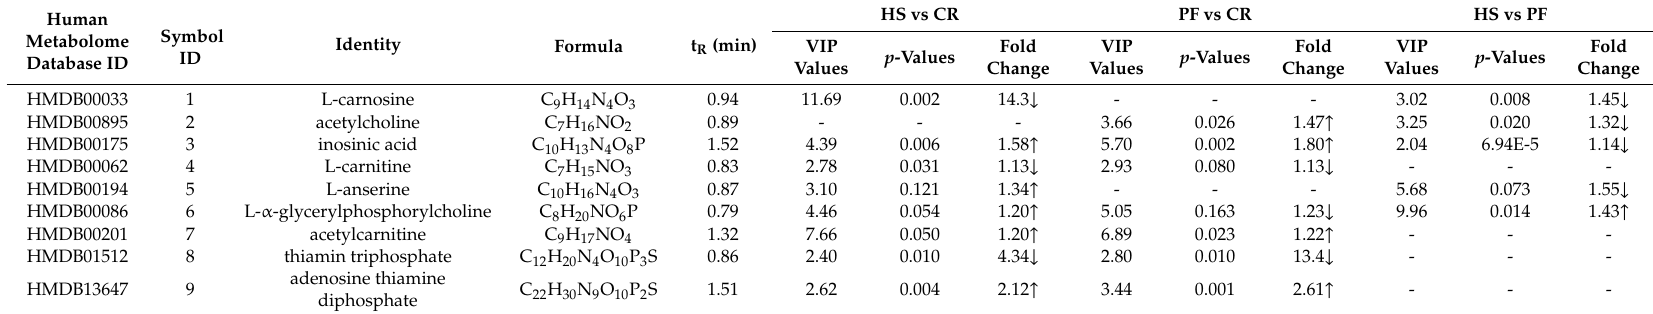
Table 1. Di ff erential metabolites in the longissimus dorsi (LD) muscle of the heat stress group (HS, n = 8), feed-intake pairing group (PF, n = 8), and the control group (CR, n = 8) in ESI-positive